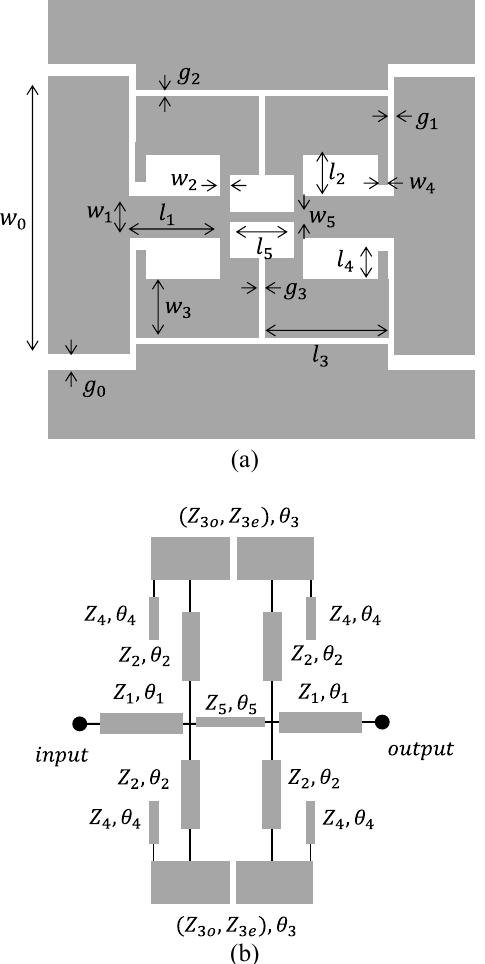
Figure 1: (a) Layout of the proposed LUC ( w 0 =7.5 mm, g 0 =0.6 mm, w 1 =1.4 mm, l 1 =1.5 mm, g 1 =0.1 mm, w 2 =0.3 mm, l 2 =1 mm, g 2 =0.1 mm, w 3 =1.5 mm, l 3 =2.2 mm, g 3 =0.1 mm, w 4 =0.2 mm, l 4 =0.9 mm, w 5 =0.15 mm and l 5 =1.1 mm) and (b) Its corresponding transmission line circuit.